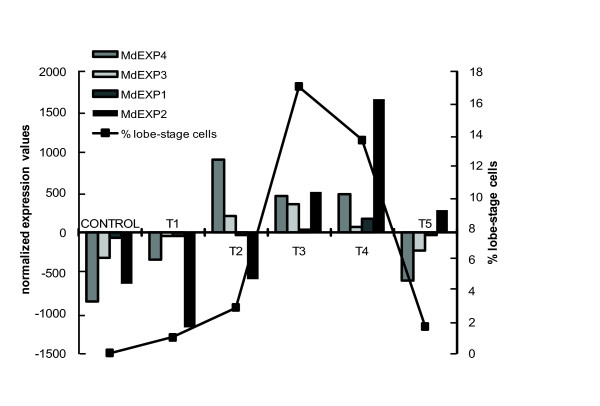
Normalized cDNA-AFLP expression values of Micrasterias denticulata expansin-resembling proteins in synchronized cultures in relation to the proportion of lobe-forming cells in these cultures. The samples (T1-T5) are defined in Figure 1D.